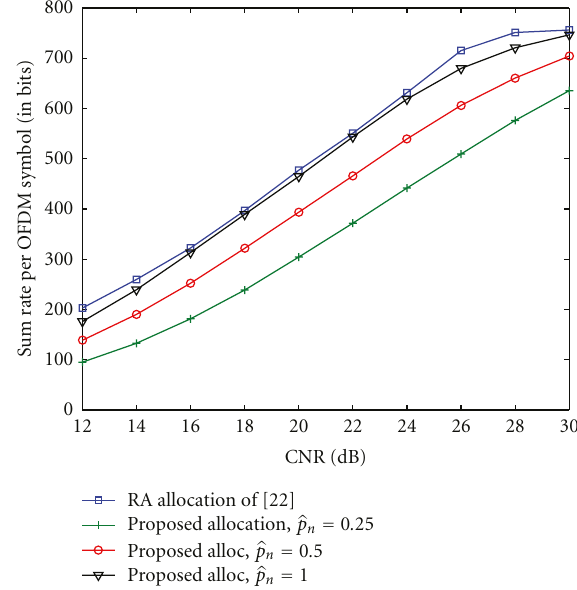
Figure 4: Comparing average number of bits transmitted per OFDM symbol, with N = 128 subcarriers, and K = 3